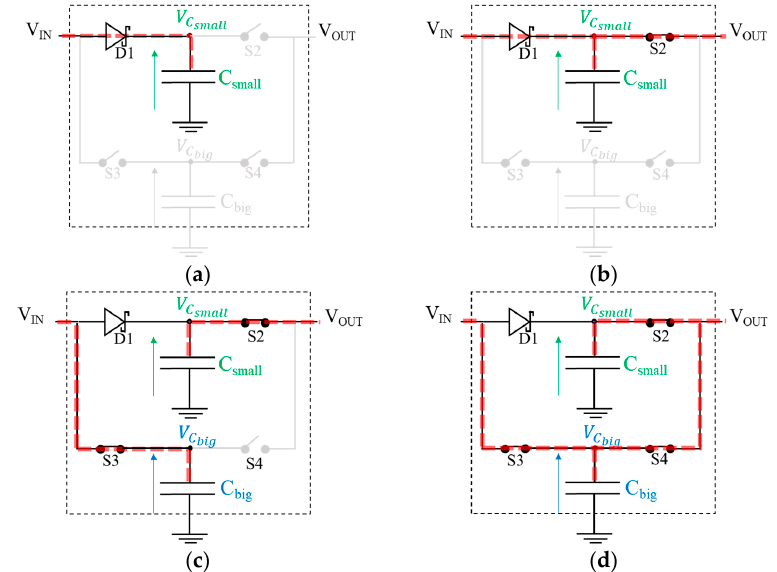
Figure 4. The different operation modes of the proposed variable storage architecture: ( a ) charge of C small only via D1 Schottky diode; ( b ) when reaching V max1 threshold, S2 switch is closed and C small supplies the load; ( c ) C small continues to charge; when reaching V max2 threshold, S3 switch is also closed to charge C big and C small supplies the load until reaching maximum discharge threshold V min2